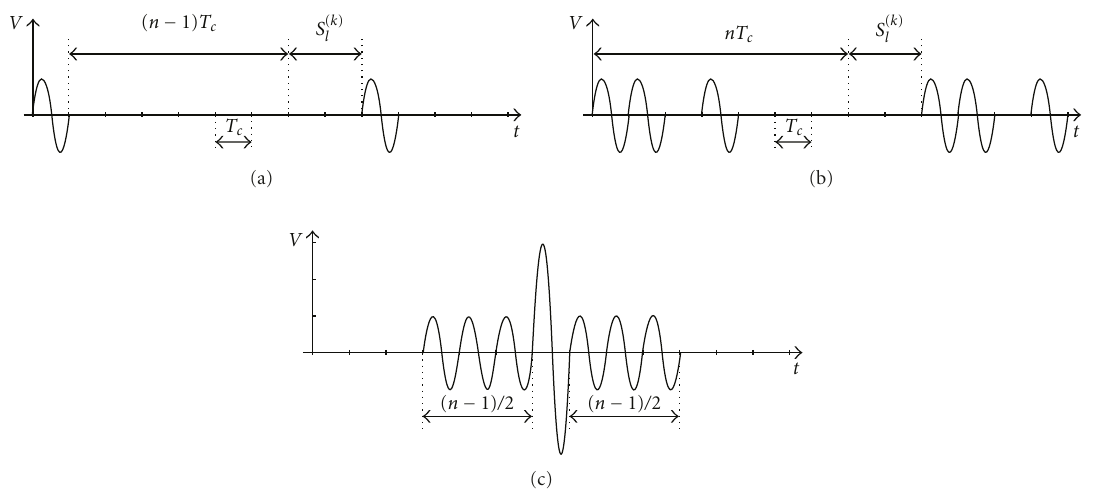
Figure 4: PIM symbol (a) before the TDL encoder, (b) after the TDL encoder, (c) after the TDL